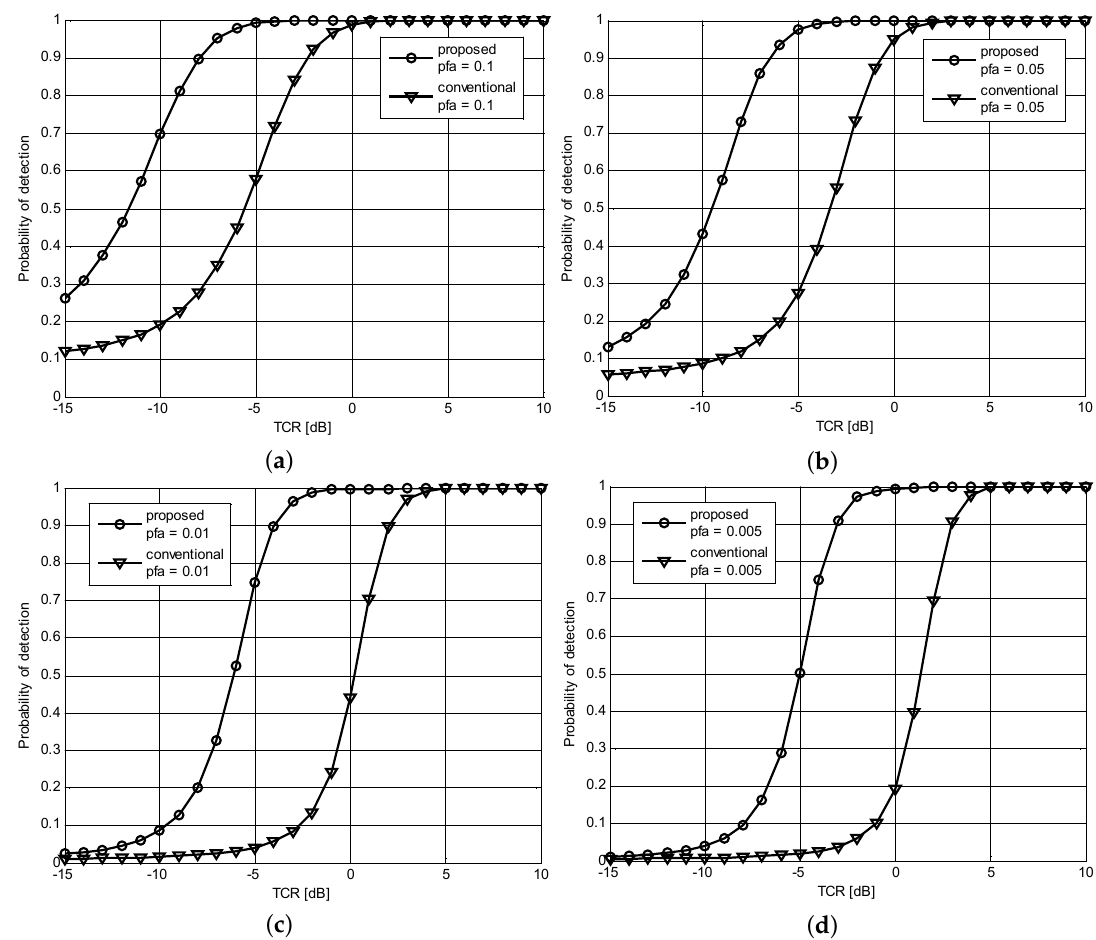
Figure 2. Probabilities of detection numerically obtained by the proposed and conventional methods for P FA = 0.1, 0.05, 0.01, and 0.005 with α = 1 and λ = 1. ( a ) P FA = 0.1; ( b ) P FA = 0.05; ( c ) P FA = 0.01; ( d ) P FA = 0.005. P FA : false alarm probability ; TCR: target-to-clutter ratio.